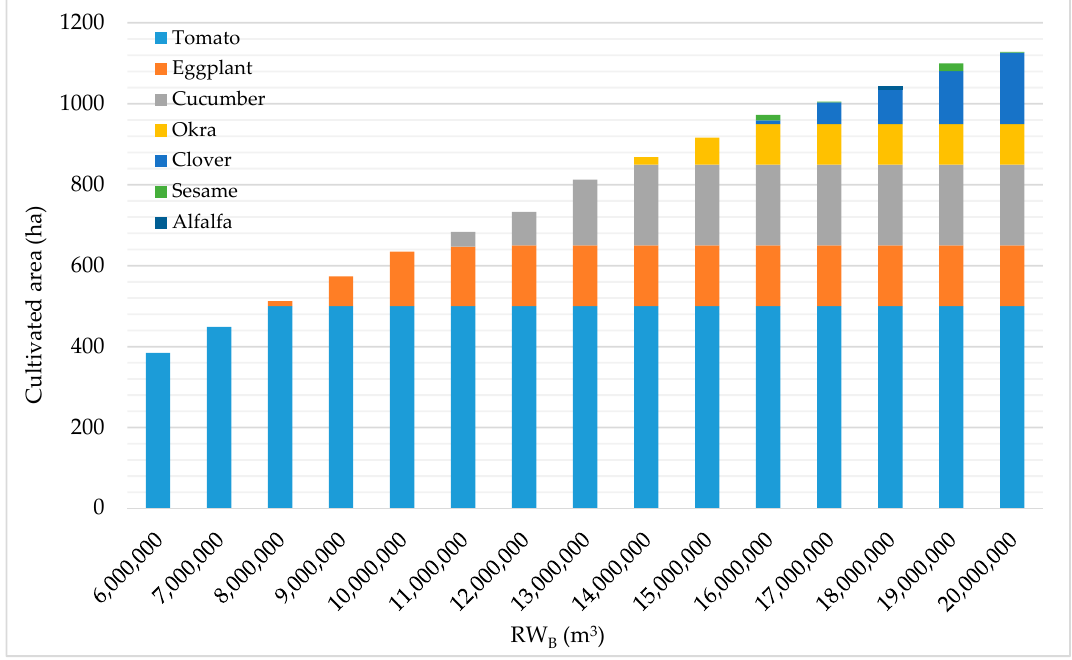
Figure 11. Predicted area (ha) of crops irrigated using reclaimed water type B (RW B ) with 45% IE.